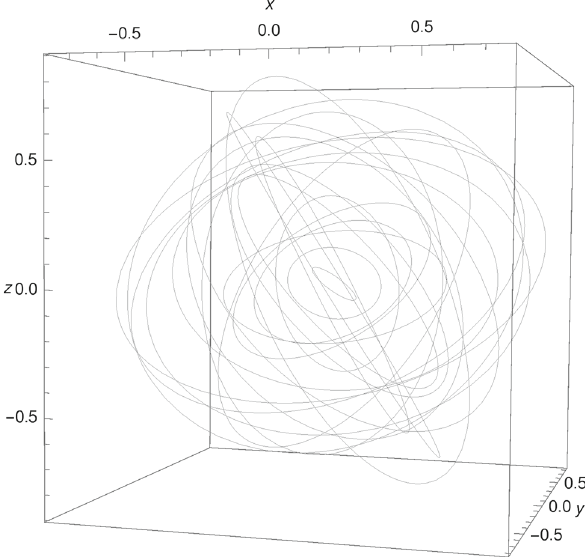
Fig. 1 Thesolutioncalled‘Einsteincluster’isameanfieldapproxima- tionofaspacetimefilledwithahighnumberofmassiveparticlesmoving in their own gravitational field on randomly inclined and directed circu- lar orbits. (The Cartesian coordinates x , y , z were scaled for